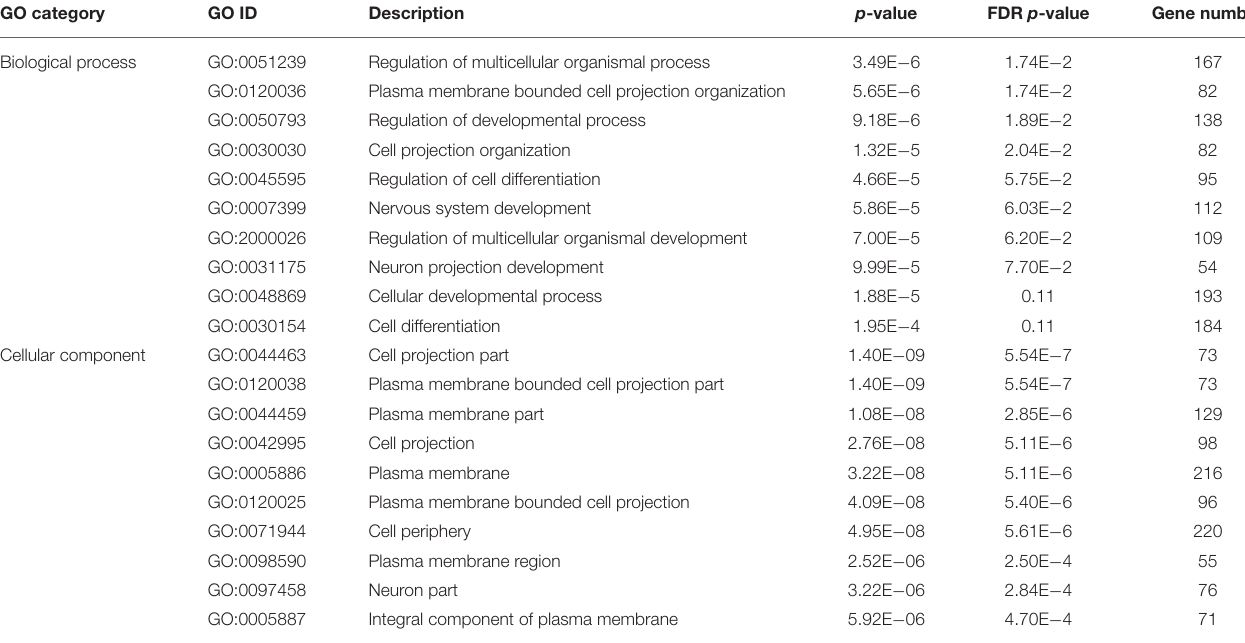
TABLE 4 | GO analysis for potentially functional private genes of herding dogs. GO